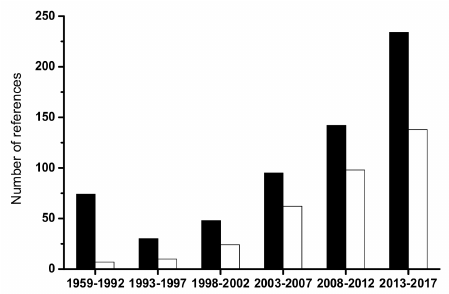
Figure 1. Number of references related with “ Brettanomyces ” (black bars) and with “ Brettanomyces or Dekkera and wine” (white bars) retrieved from Scopus search engine